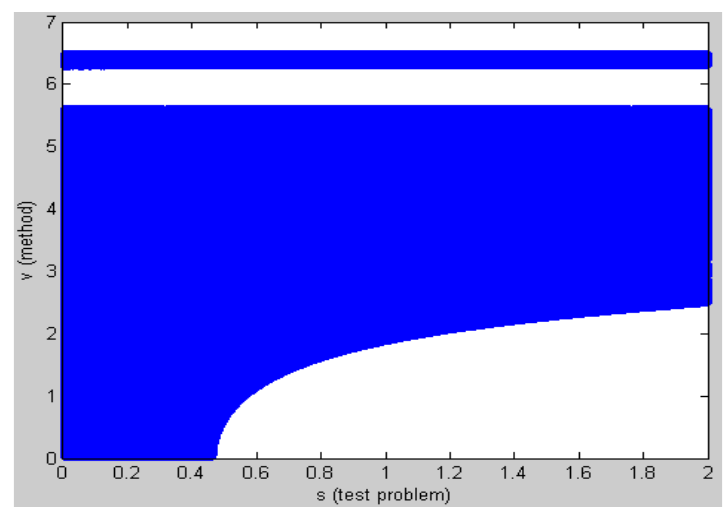
Figure 3. Stability region for the newly developed